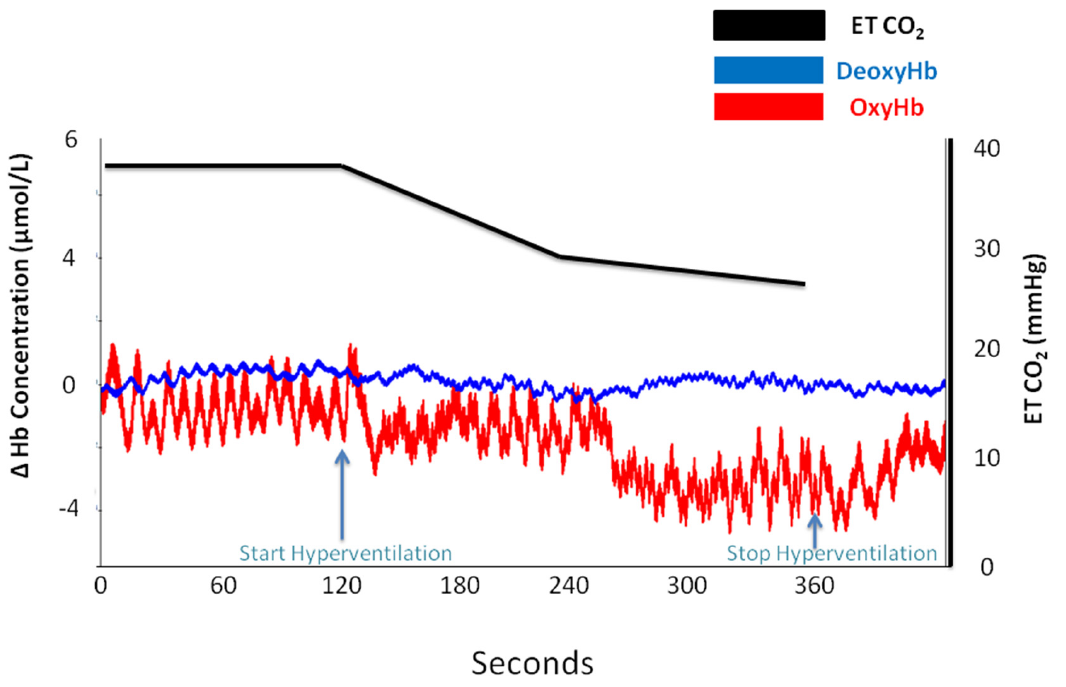
Figure 2. Oxyhemoglobin (oxyHb) and deoxyhemoglobin (deoxyHb) and end-tidal CO 2 changes at baseline and during hyperventilation and post-hyperventilation periods in the case of a subject who presented a drop in oxyhemoglobin.